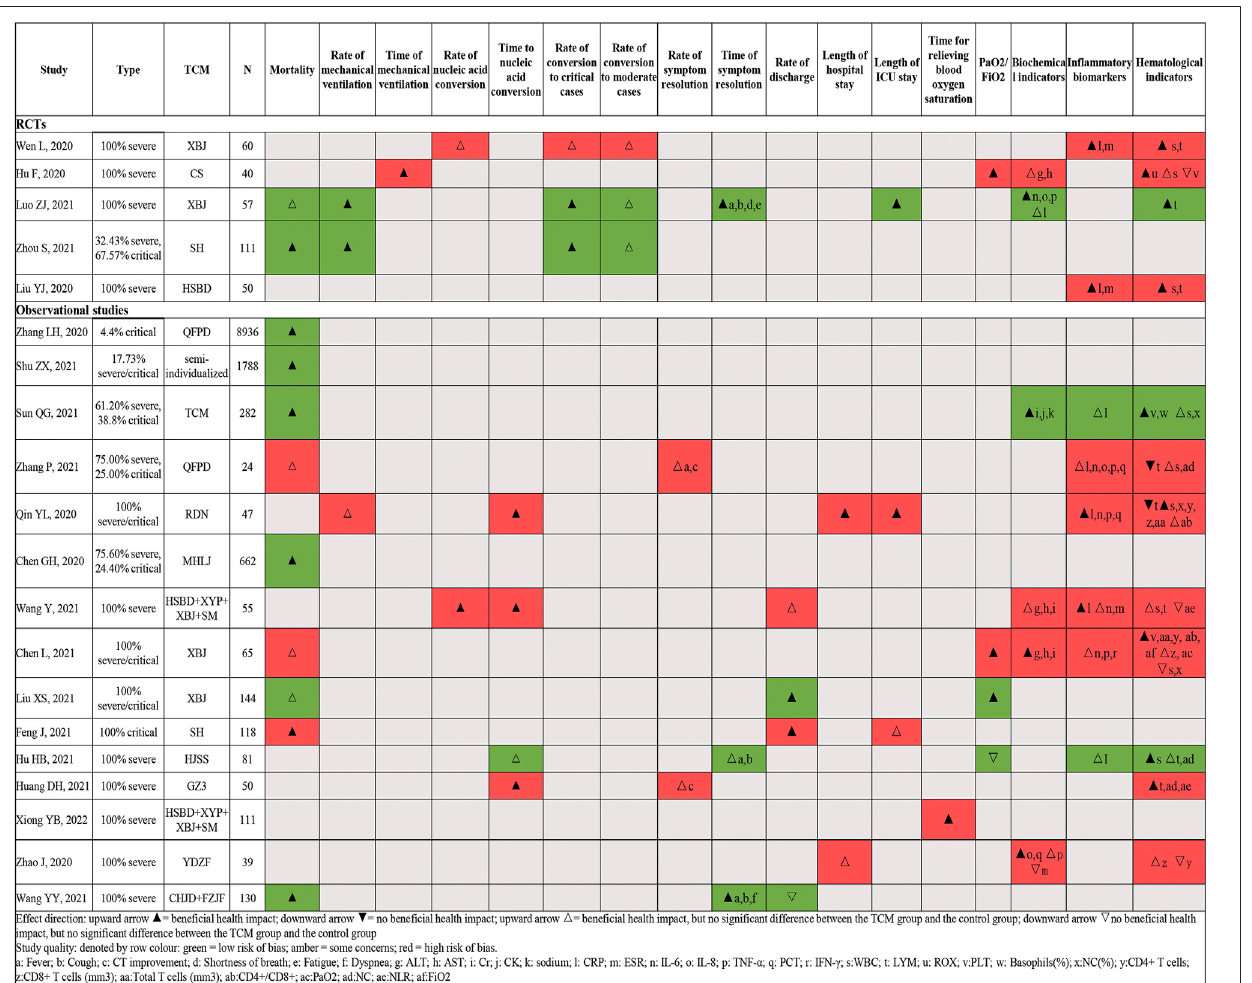
FIGURE 3 | Effect direction plot summarizing direction of health impacts from each single study.